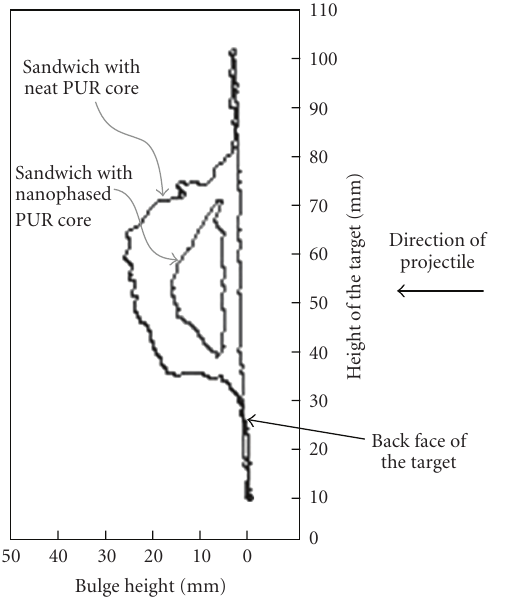
Figure 9: Bulge contours of neat and nanophased